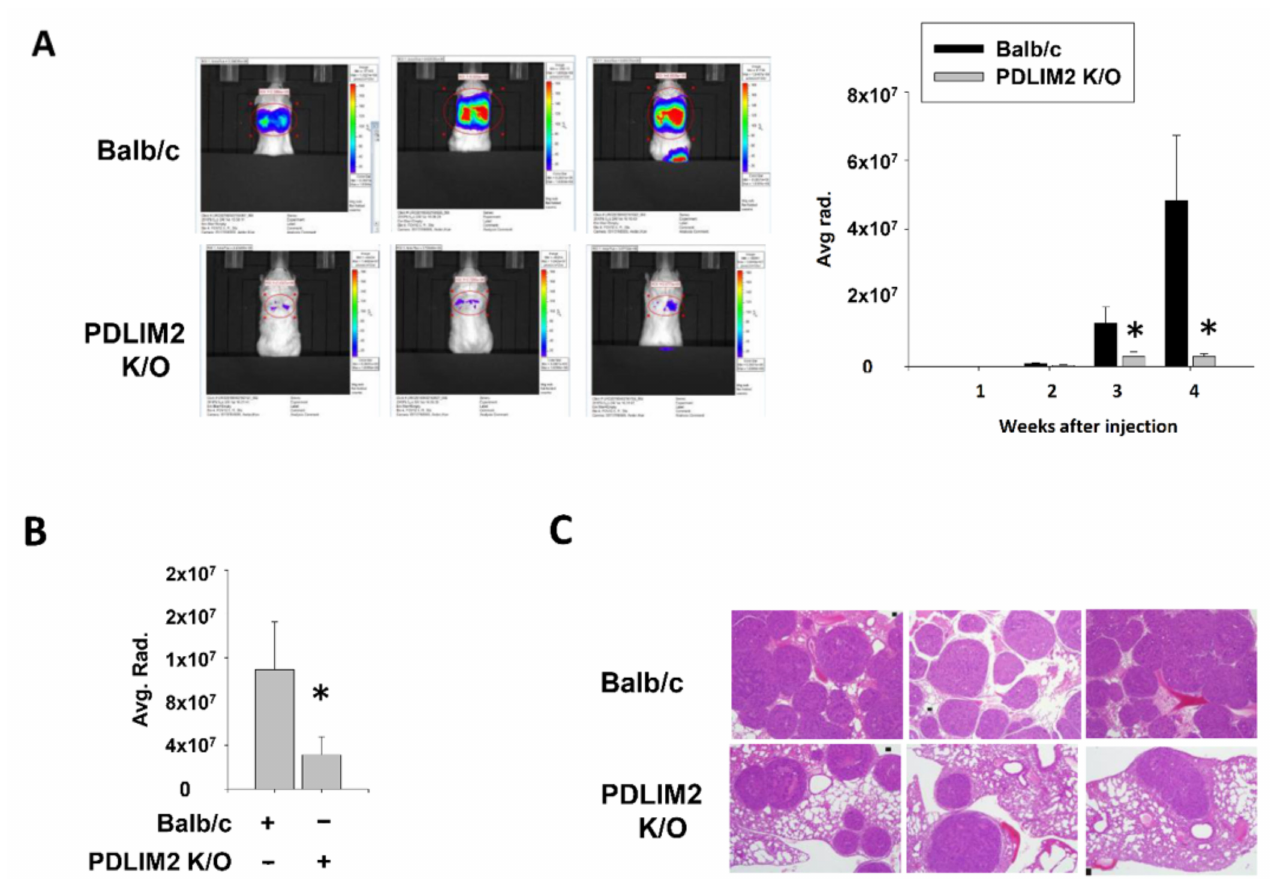
Figure 6. PDLIM2 knockout mice showed decreased metastatic tumors in tail vein injected model of RenCa murine kidney cancer cells. ( A ) Bioluminescent images from the indicated mice at the day of sacrifice. Time dependent bioluminescent flux plot quantifying tumors are graphed left. Error bars represent means ± SEM of each group ( n = 10). * p < 0.05 (Student’s t -test) versus the control Balb/c group. ( B ) Bioluminescent flux plot from the extracted lung from each group. Error bars represent means ± SEM of each group ( n = 10). * p < 0.05 (Student’s t -test) versus the control Balb/c group. ( C ) Representative hematoxylin-eosin staining images of the lung metastasis